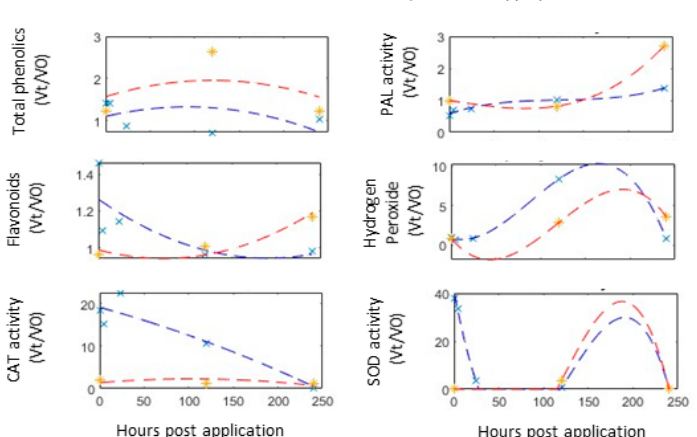
Figure 5. Mathematical modeling of plant immune responses to non self eDNA ( Fusarium eDNA at 15 ppm) applied in adult plants. Data showed in normalized dimensionless values for each sampling time in hours post treatment application. Blue lines represent responses to first application and red lines represent responses to second application of treatment.